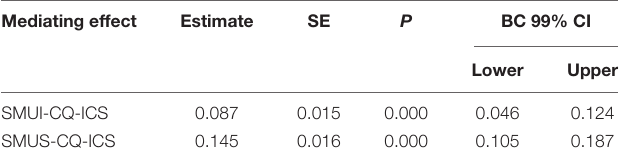
TABLE 4 | Results of the mediating effect. TABLE 5 | Results of hierarchical regression analyses for